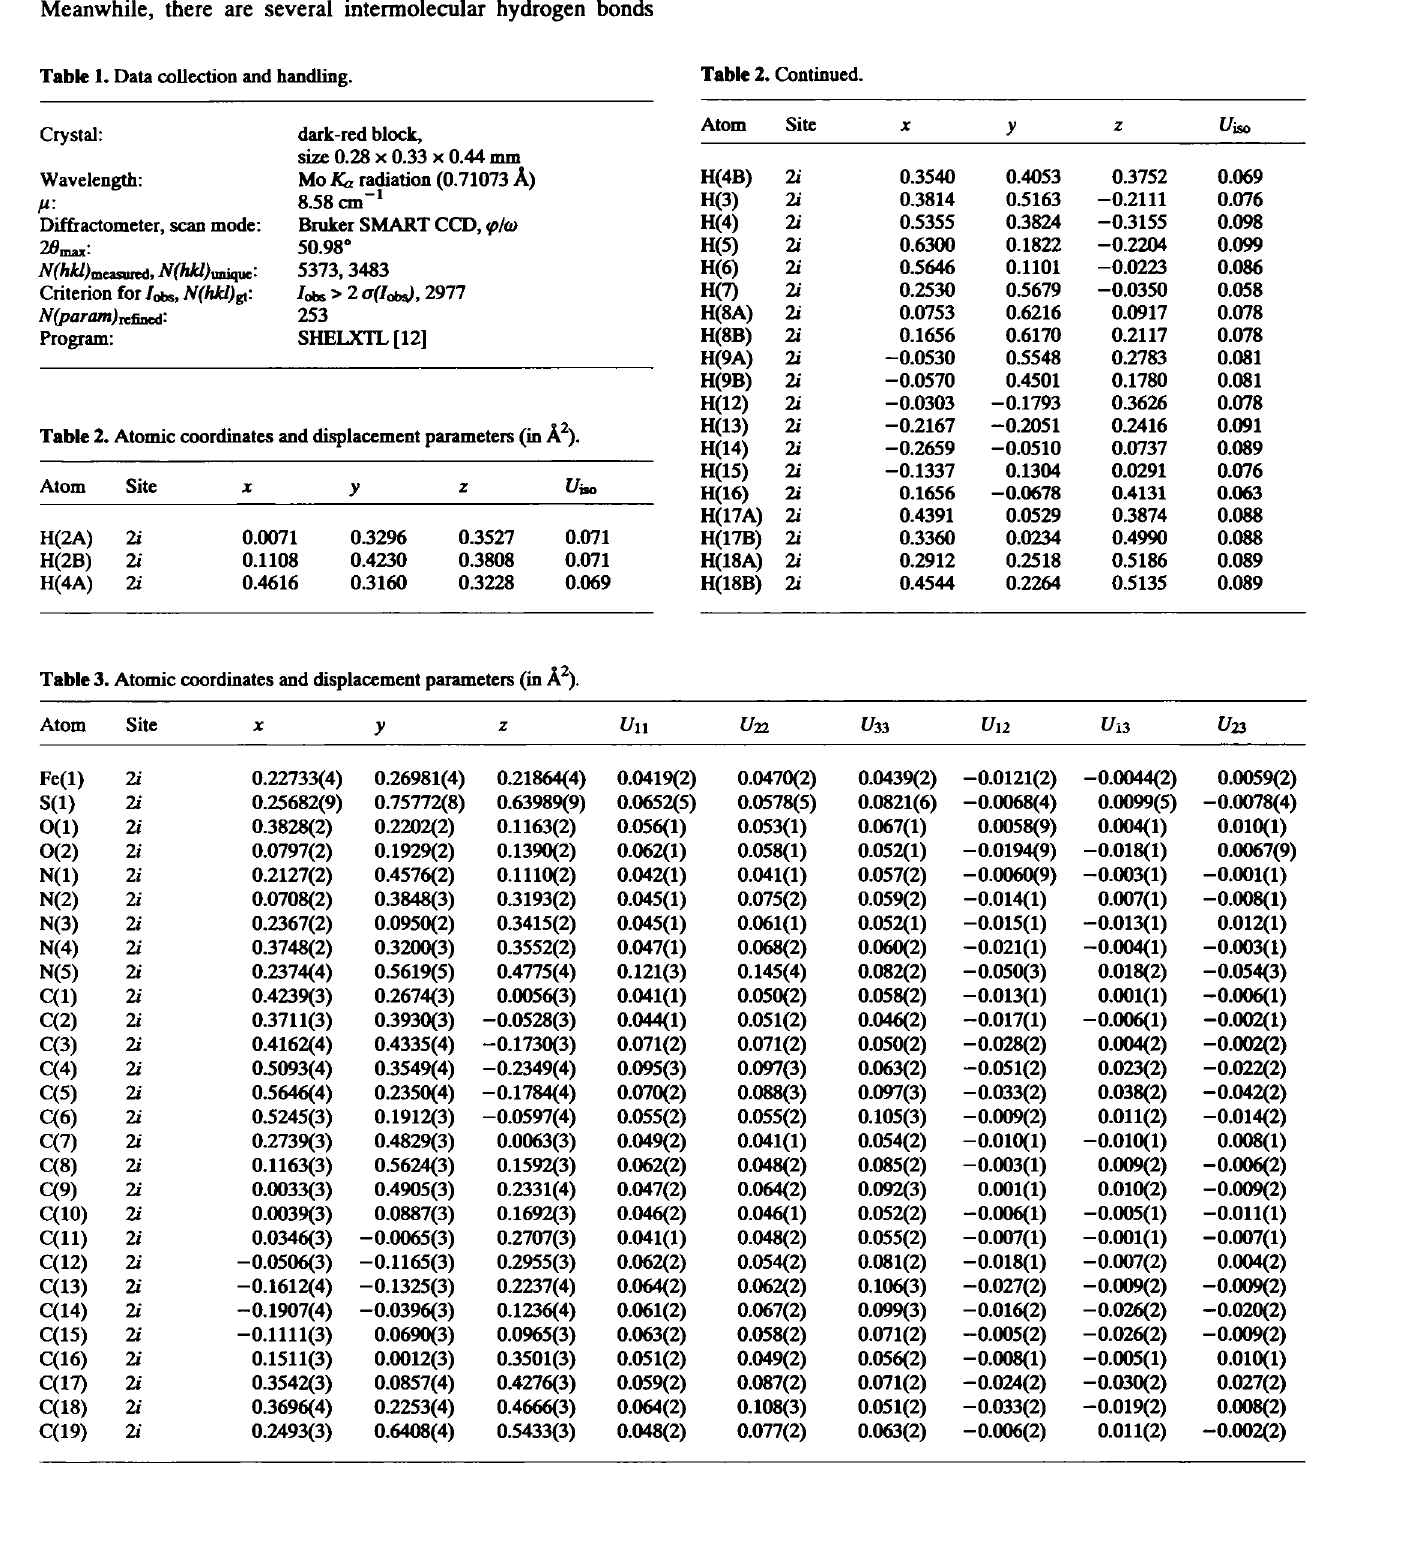
Table 2. Atomic coordinates and displacement parameters (in A 2 ).